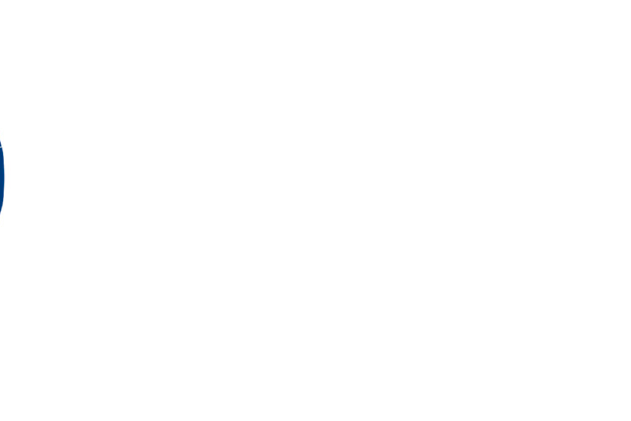
Figure 3. Communication campaigns for farmers and extension services were created to explain the soil nutrient intensity, buffering, and quantity concepts ( a ) (see also Rotterdam et al., 2013) [72] and the soil fertility concept (physical, biological, and chemical soil fertility) ( b ). The arrows in ( a ) represent the buffering processes through dissolution/desorption (to the right) and adsorption/precipitation (to the left). A metaphor is used to explain the soil nutrient intensity, buffering, and quantity concepts (food on the ‘plate’, ‘kitchen’, and ‘basement’).